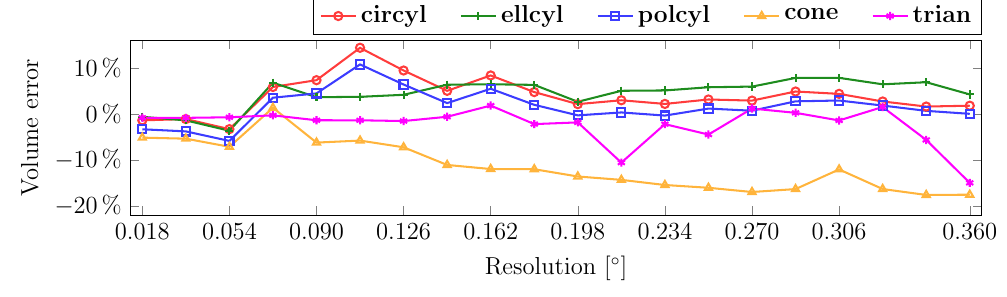
Figure 10. Effect of the angular sampling resolution on the reconstructed surface area and volume of Stem